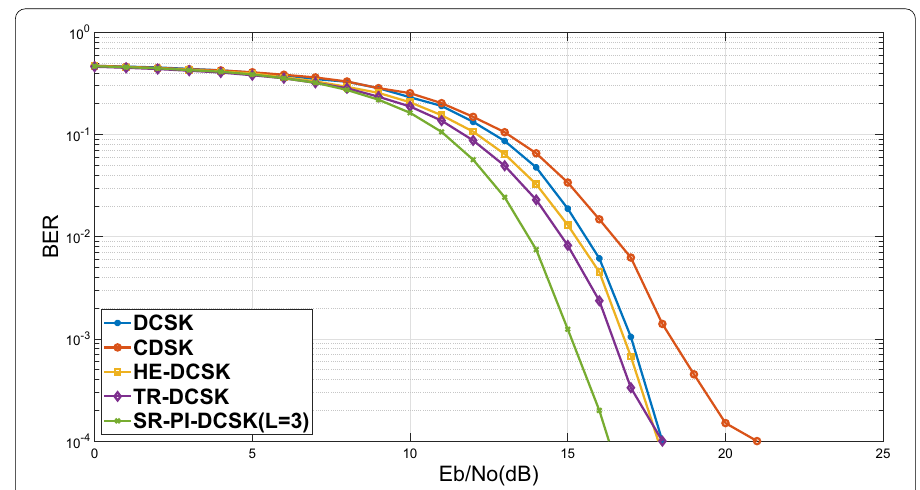
Fig. 6 The bit error rate performance of SR‑PI‑DCSK versus DCSK, CDSK, HE‑DCSK, and TR‑DCSK for β